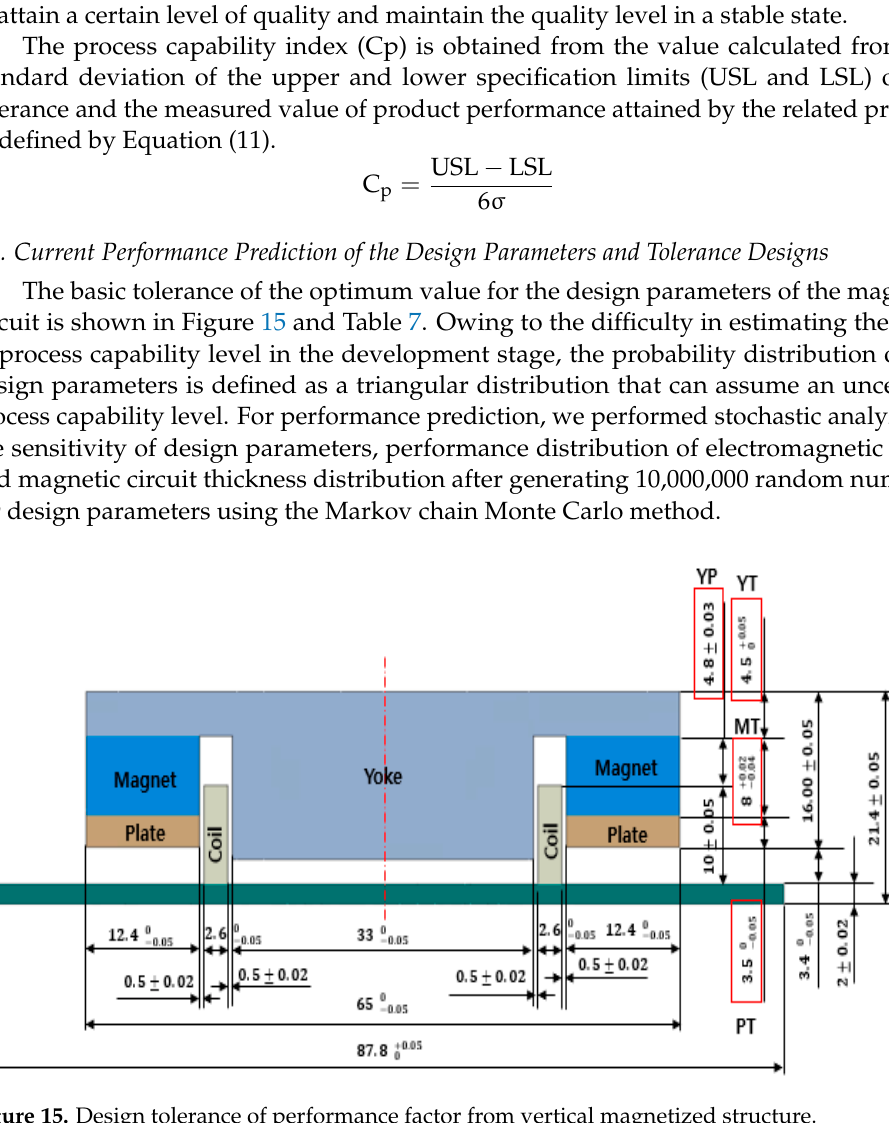
Figure 15. Design tolerance of performance factor from vertical magnetized structure. Table 7. Range of design tolerance for performance factor.